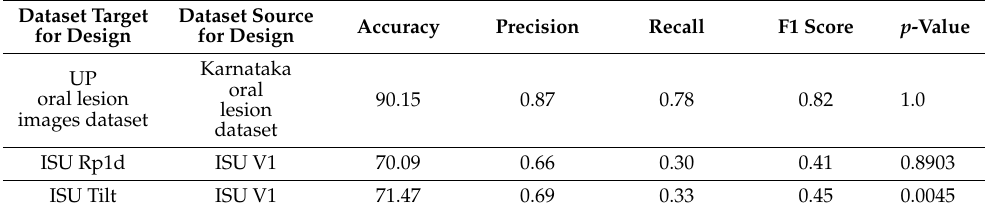
Table 15. Results of running the SPHH with transfer learning for the image processing datasets. Dataset Target for